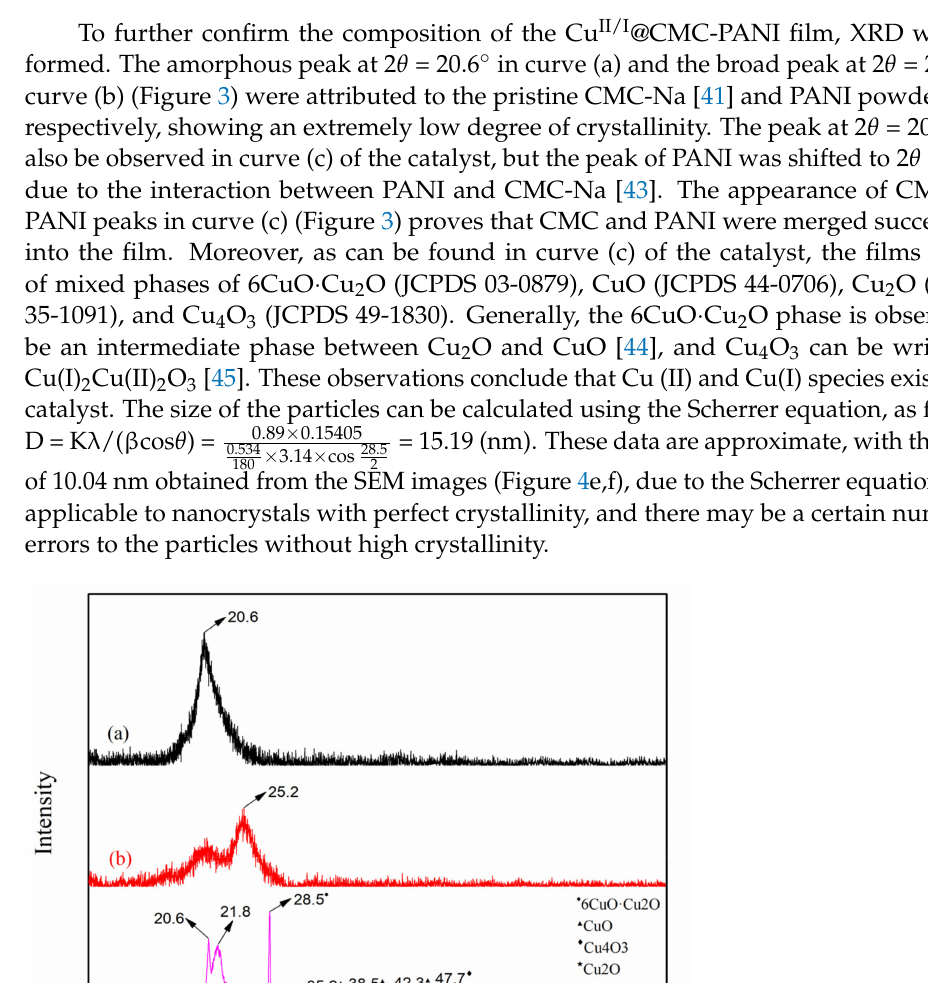
Figure 2. The XPS survey scan ( a ) of Cu II/I @CMC-PANI film and its high-resolution spectra of C 1s ( b ), N 1s ( c ), O 1s ( d ), Cu 2p ( e ) and Cu LM2 ( f ); XPS high-resolution spectra of Cu 2p ( g ) and Cu LM2 ( h ) of catalyst recovered from A 3 reaction.